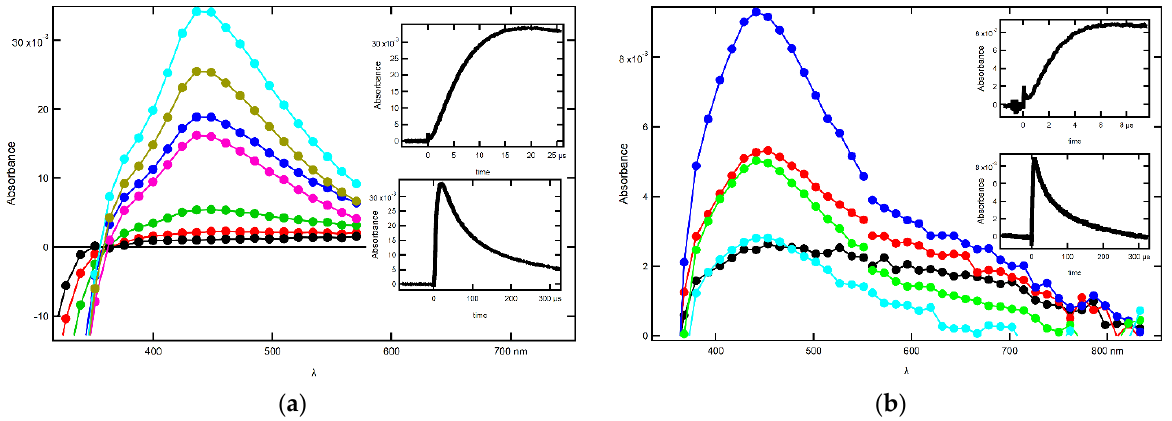
Figure 7. Transient absorption spectra recorded in N 2 O-saturated unbuffered aqueous solutions containing 30 mM of NaN 3 and 0.05 mM of 2-SeU: ( a ) at pH = 6, 500 ns (  ), 1 μ s (  ), 2 μ s (  ), 6 μ s (  ), 18 μ s (  ), 50 μ s (  ), and 100 μ s (  ) after electron pulse; ( b ) at pH 10, 1 μ s (  ), 2 μ s (  ), 7 μ s (  ), 50 μ s (  ), and 100 μ s (  ) after electron pulse. Insets: time profiles representing growth (upper) and decay (bottom) of transient absorption at λ = 440